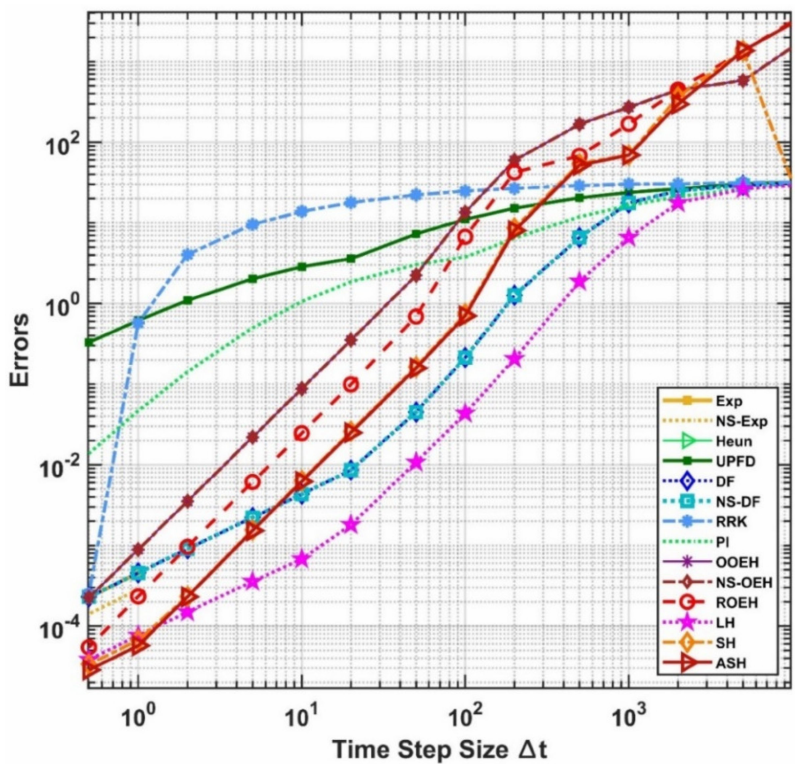
Figure 14. The maximum errors as a function of the time step size for the non-equidistant mesh.